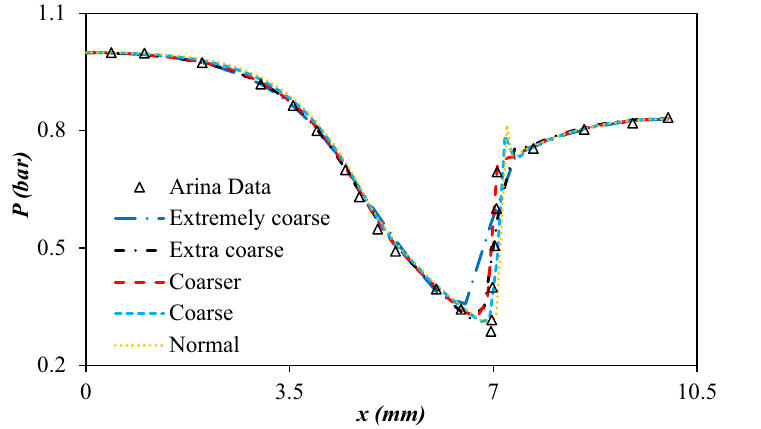
Figure 4. The influence of mesh sizes on the predicted pressure